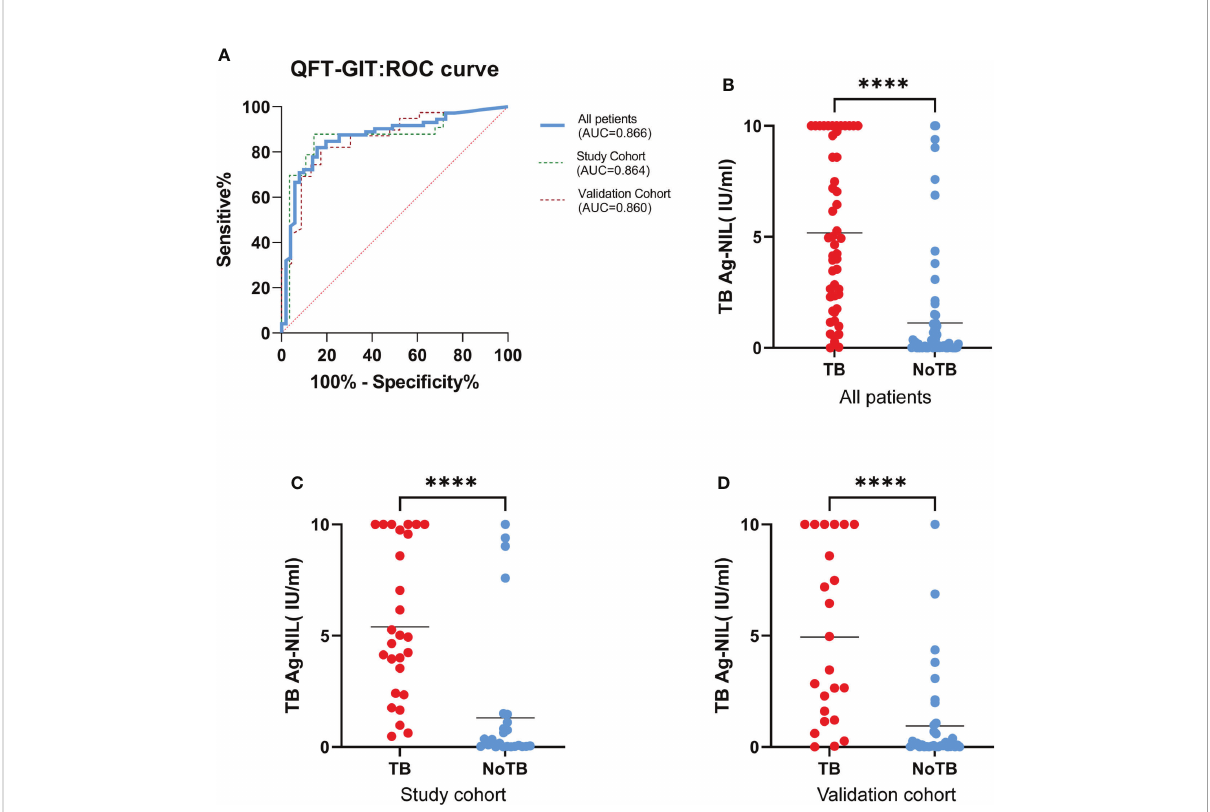
FIGURE 1 QFT-GIT diagnostic effectiveness. (A) . ROC curve by fi nal diagnosis and TB Ag-Nil values in all 123 patients, study cohort and validation cohort; (B, C, D) . TB Ag-Nil values in the TB group than in patients in the NTB group, both in all patients, in the study cohort and in the validation. (**** means P ≤